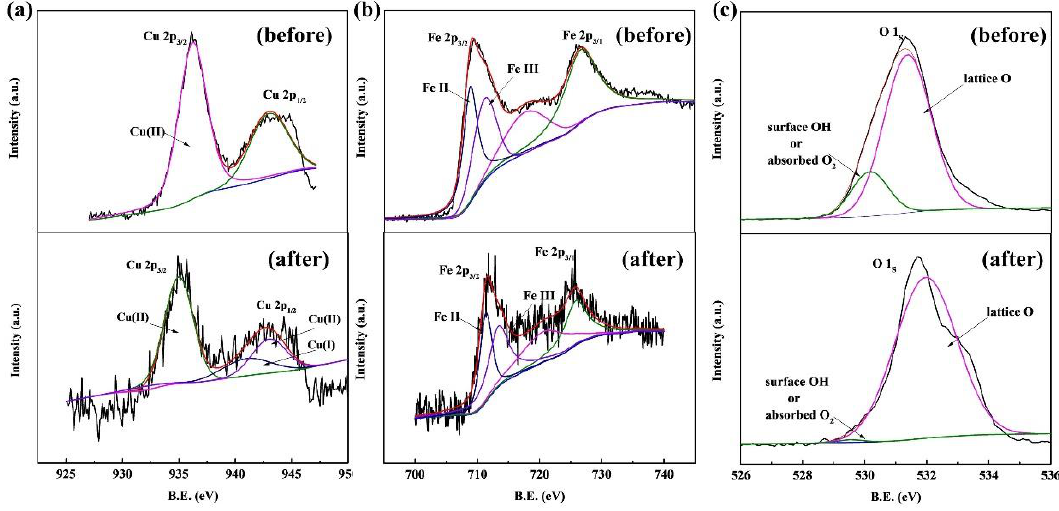
Figure 4. XPS spectra of CuFe 2 O 4 . ( a ) Cu. ( b ) Fe. ( c ) O.